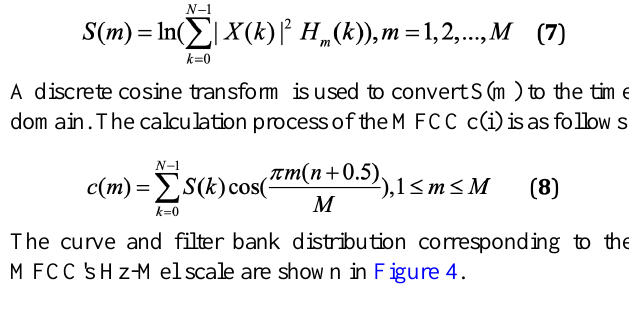
Figure 4. Mel Frequency Cepstral Coefficient (MFCC) scale corresponding